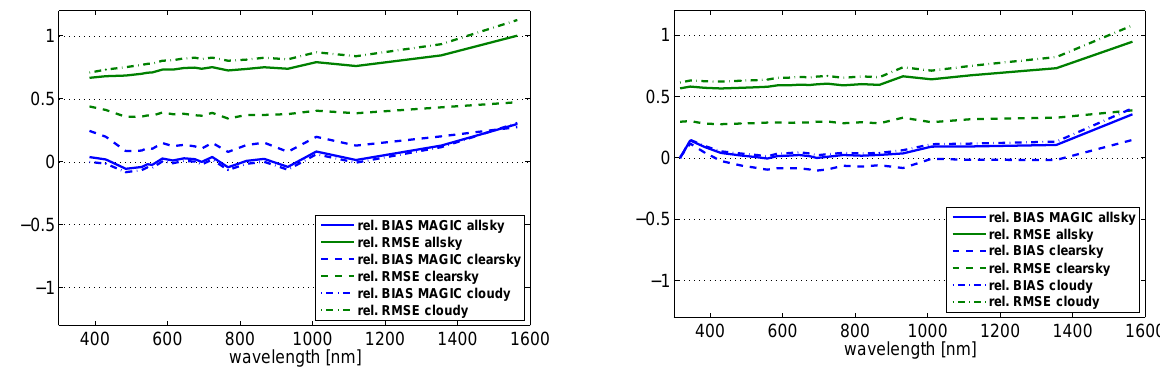
Figure 9. Relative bias and RMSE of SPECMAGIC retrieval with respect to ground measurements performed at Loughborough ( left ) and Stuttgart ( right ) for all situations, clear sky and cloudy sky.